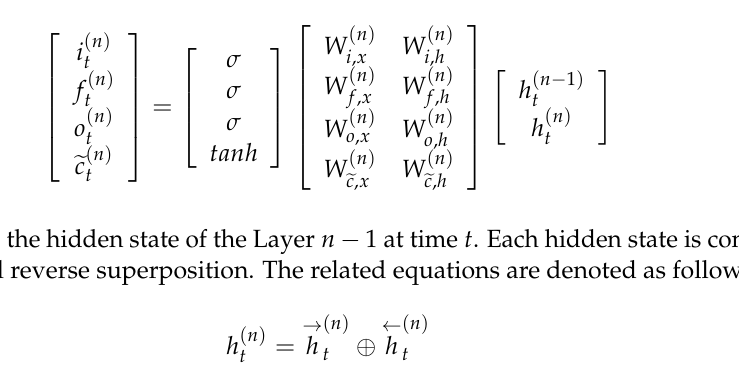
Figure 1. Information flow of multi-layer bidirectional long short-term memory (BiLSTM) network. The cell state of the Layer n BiLSTM network at time t can be presented as: